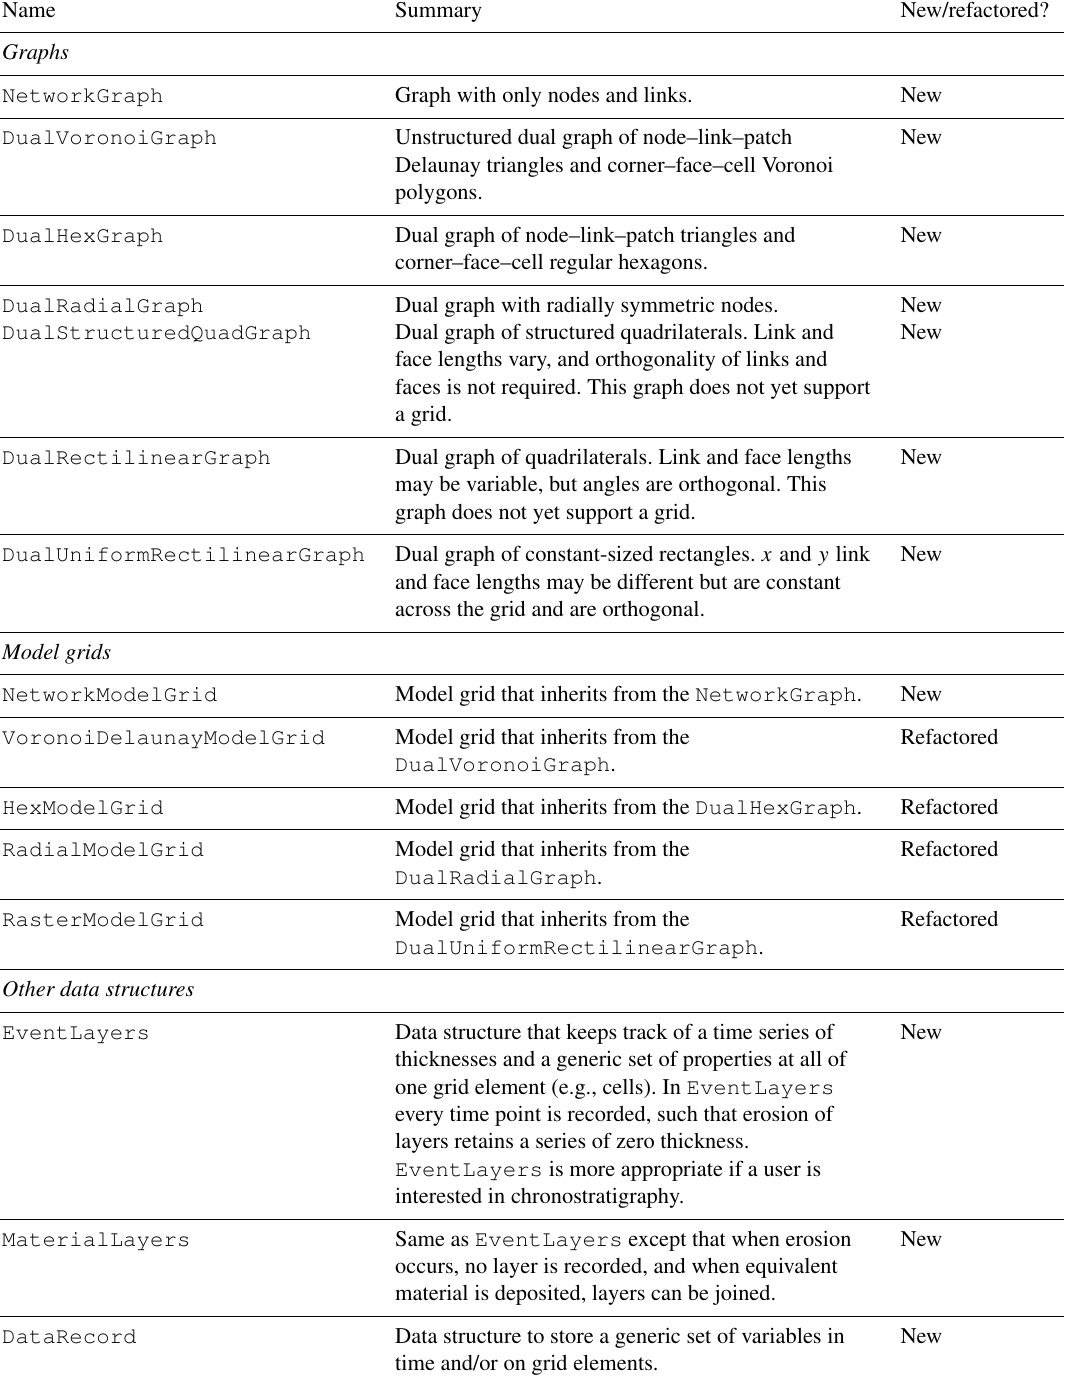
Table 1. Major data structures in Landlab